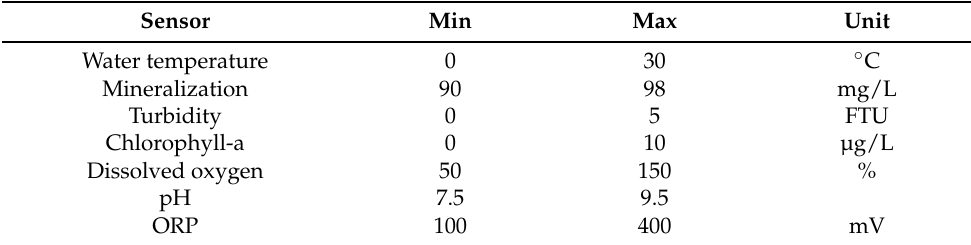
Table 2. Parameter thresholds used in the range tests.